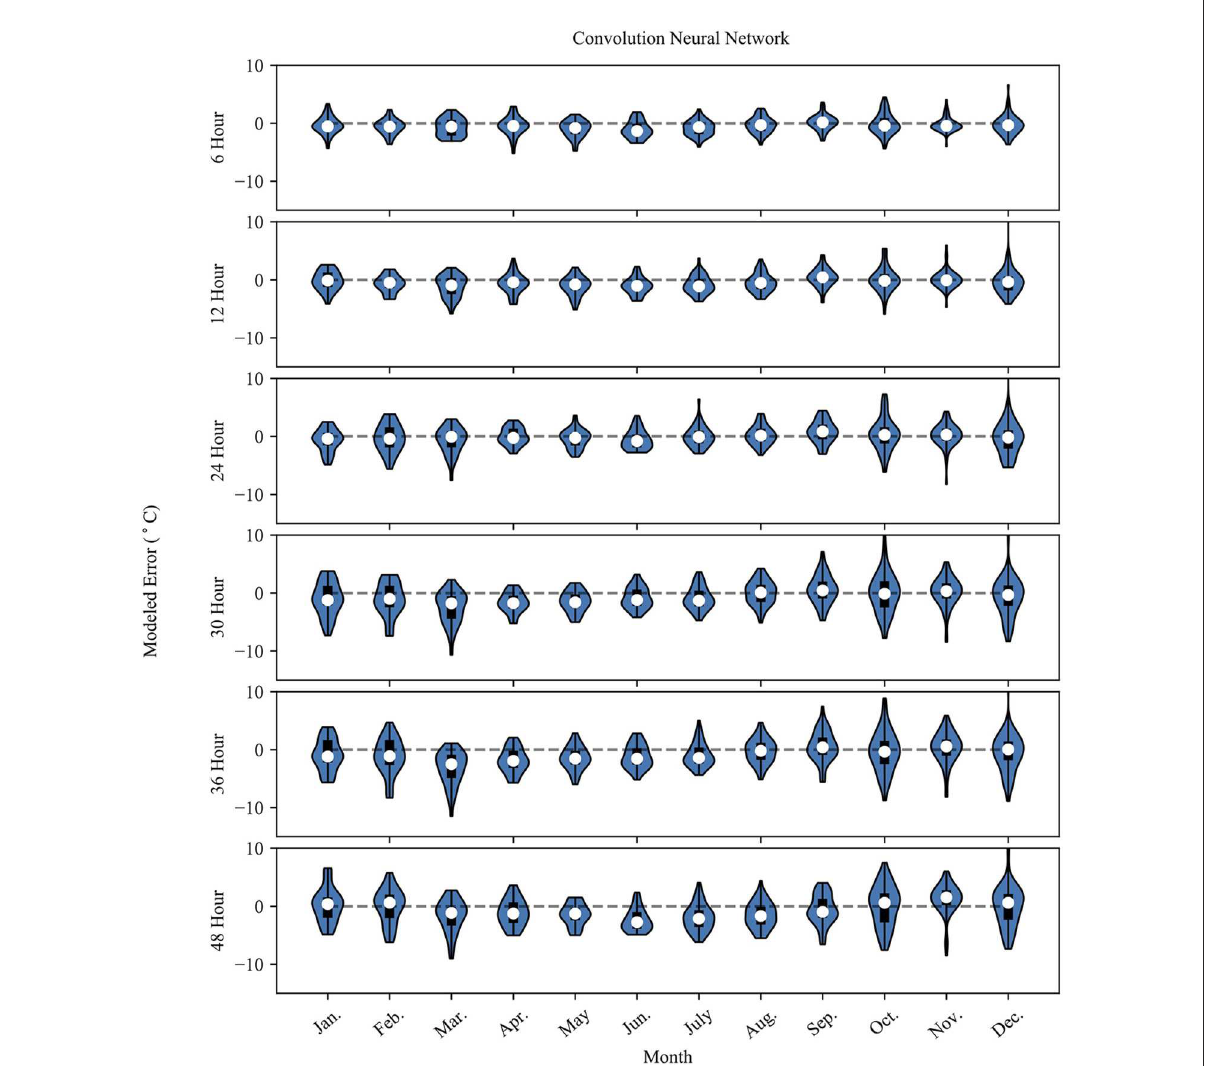
FIGURE4 The plot shows the NN model error (Error modeled – observed) grouped by month. The white dot represents the mean error for the month, = the dark box shows the 25th and 75th percentile. The whiskers extend to the minimum and maximum possible error values. The surrounding blue polygon represents the probability density of the model